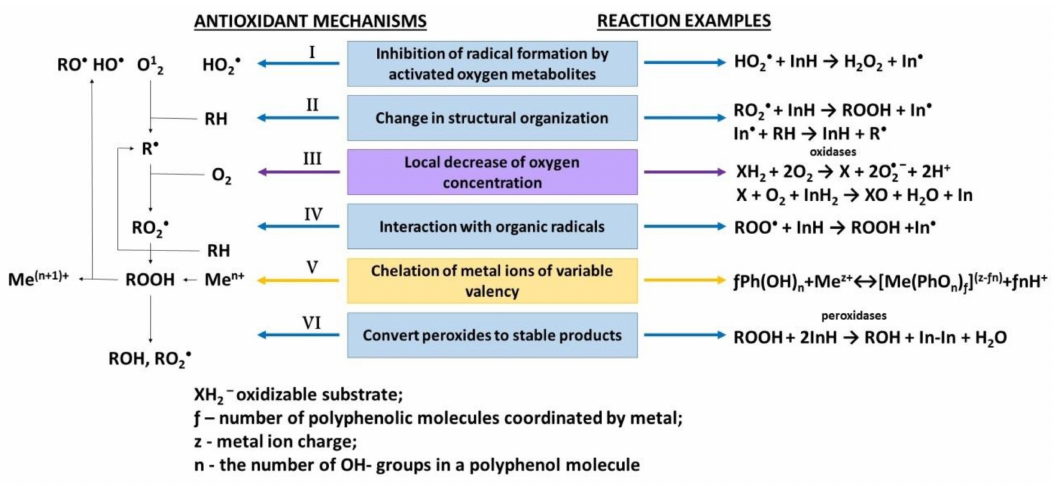
Figure 1. Mechanisms of biological action of